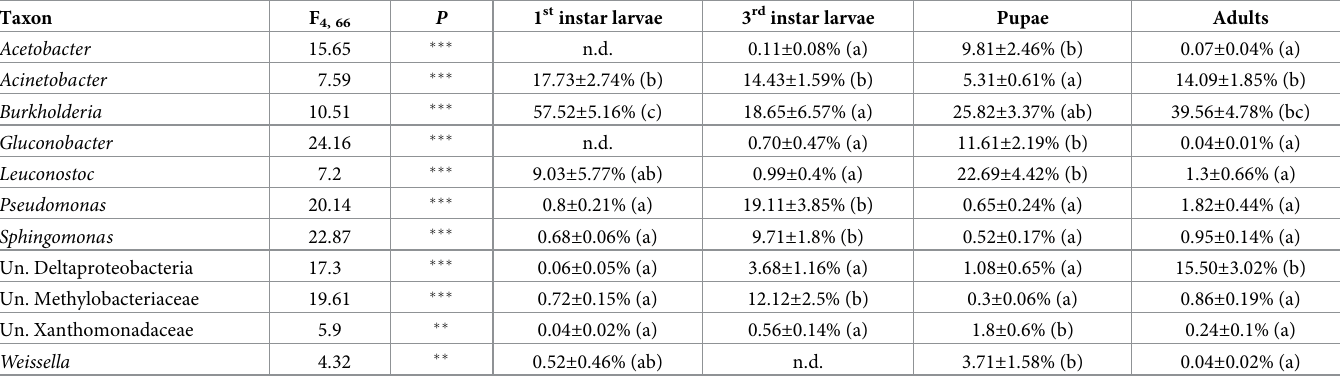
Table 1. Bacterial taxa differentially associated with different instars of C . capitata